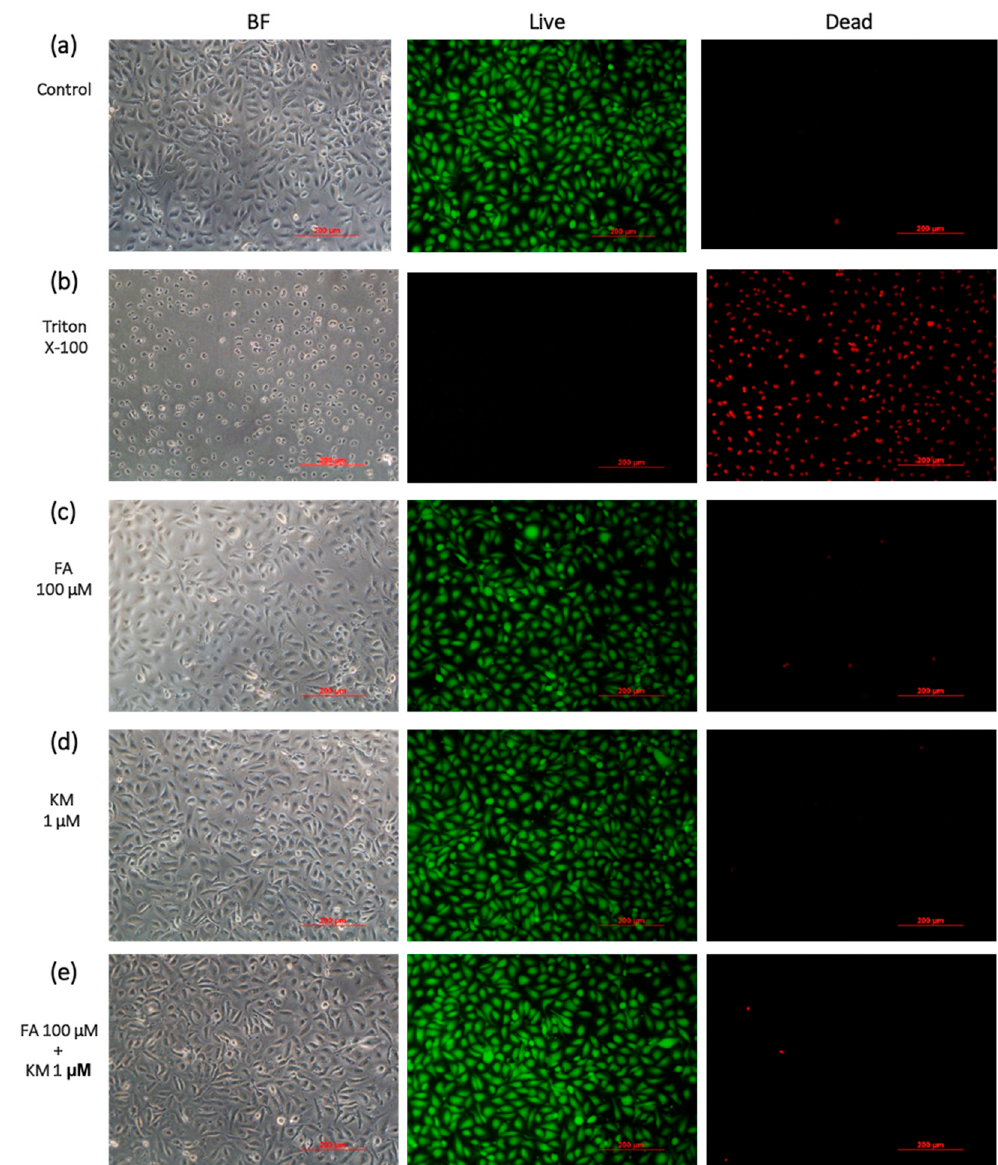
Figure 2. Live/dead staining images acquired from HCECs treated with ( a ) culture medium as the normal group, ( b ) Triton X-100 as a negative control, ( c ) FA at 100 µM, ( d ) KM at 1 µM, and their combination ( e ) FA/KM at 100/1 µM after one-day cultivation. BF: bright field; green: live cells; red: dead cells (Scale bare: 200 µm).